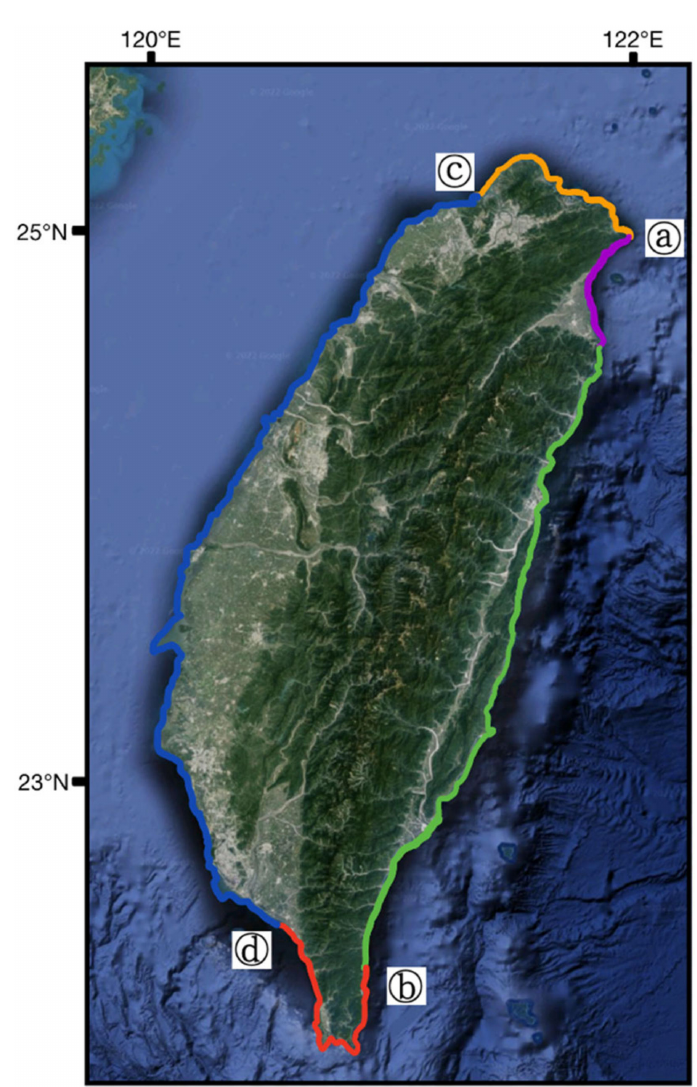
Figure 1. The study area of